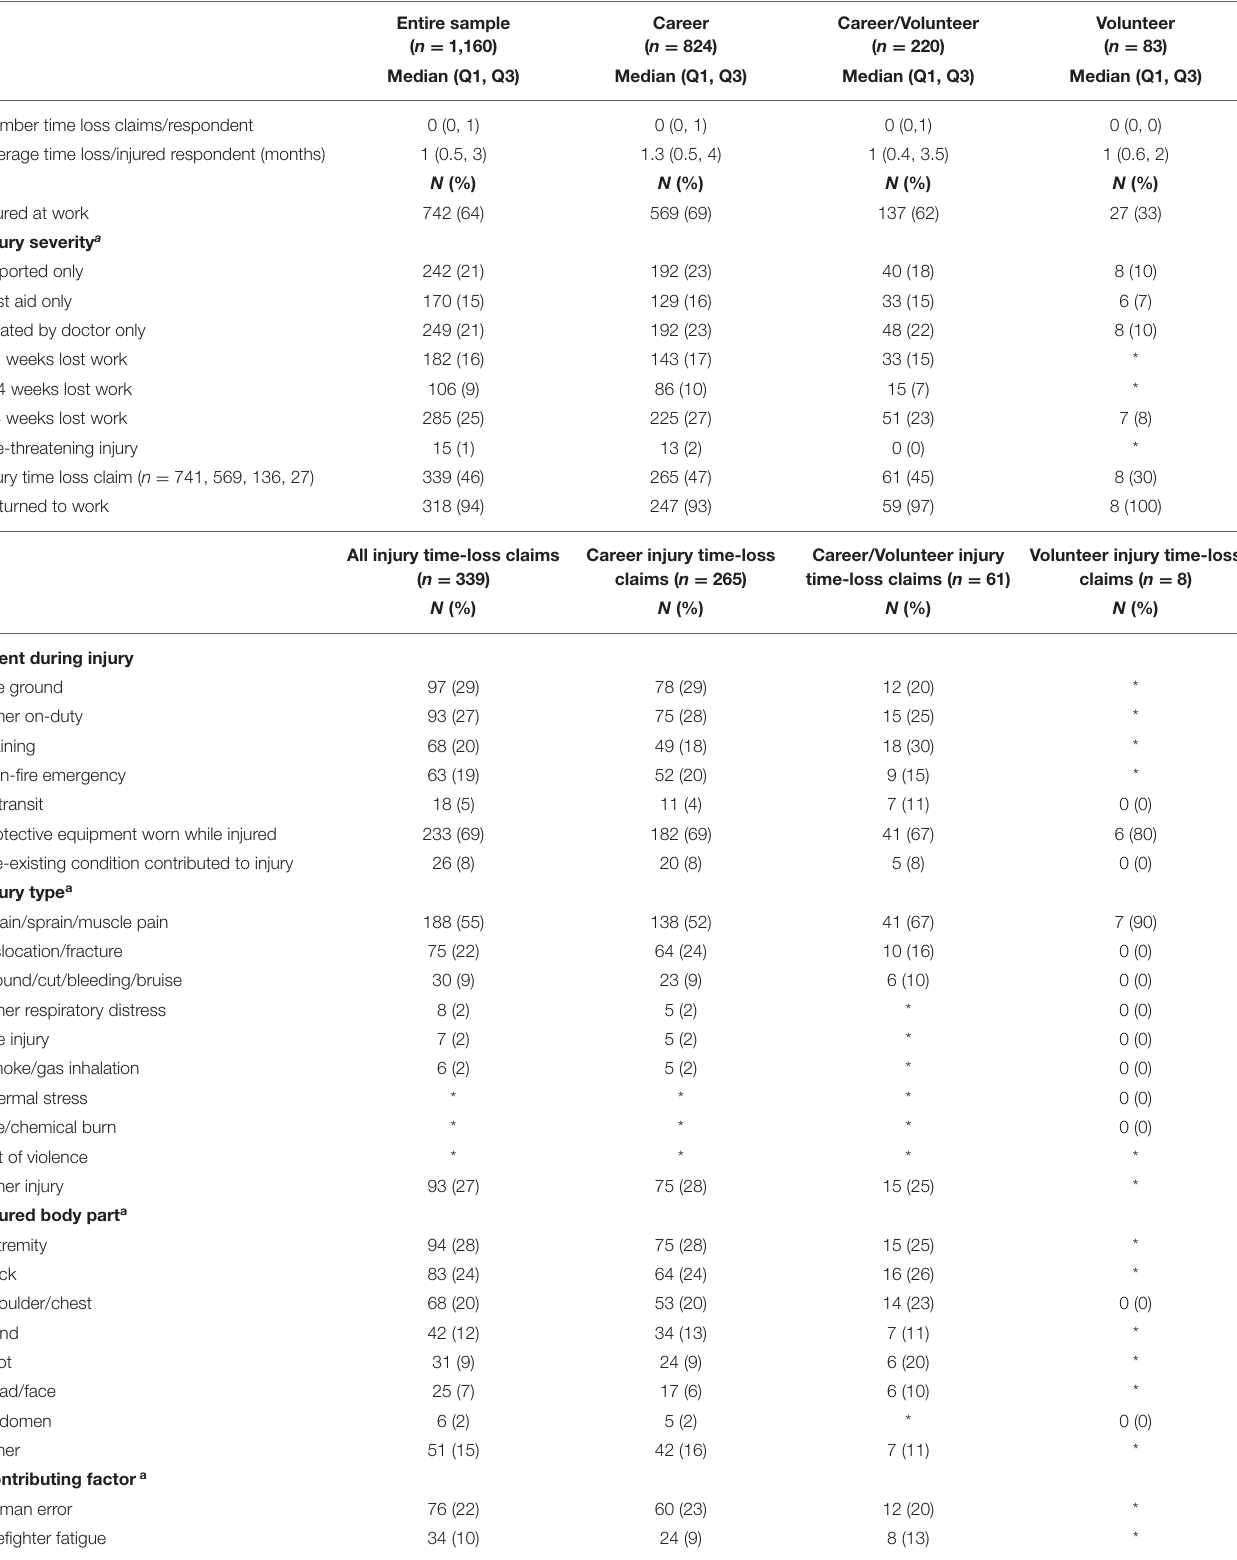
TABLE 4 | Characteristics of work-related injuries among active female firefighters in the US and Canada, by